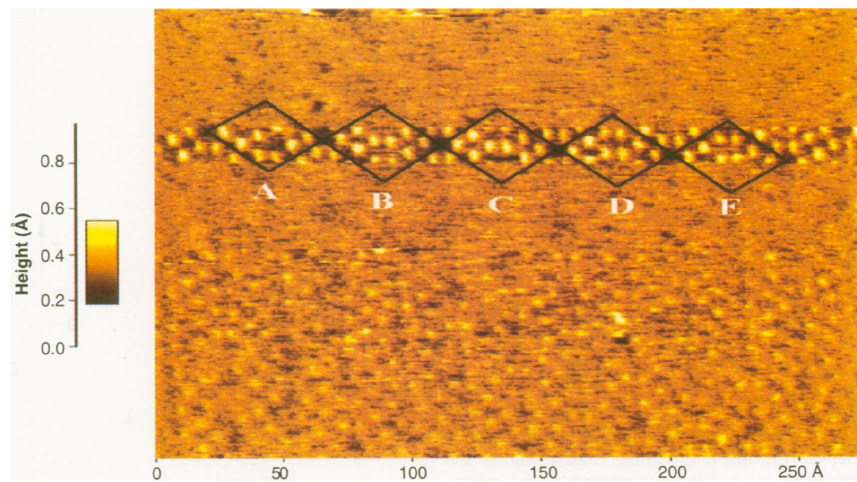
Figure 4. First atomically resolved AFM image of Si(111)–(7 × 7). The image was recorded with a Si cantilever with an eigenfrequency f 0 = 114224Hz at an oscillation amplitude of A = 34nm in the topographic mode with a constant frequency shift of ∆ f = − 70Hz. Adapted with permission by the American Association for the Advancement of Science from Figure 2 in [5].